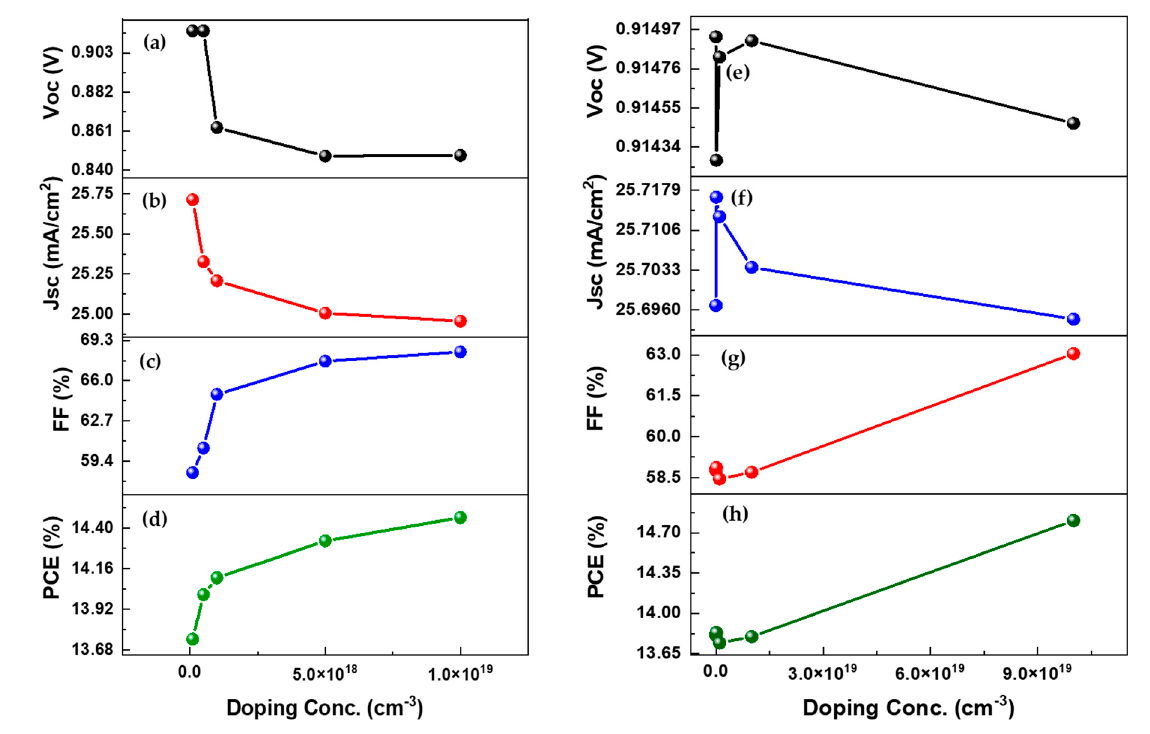
Figure 7. ( a , e ) Voc as a function of active layer and HTM layer doping density; ( a , e ) Jsc as a function of active layer and HTM layer doping density; ( b , f ) FF as a function of active layer and HTM layer doping density; ( c , g ) PCE as a function of active layer and HTM layer doping density; and ( d , h ) PCE as a function of active layer and HTM layer doping density.